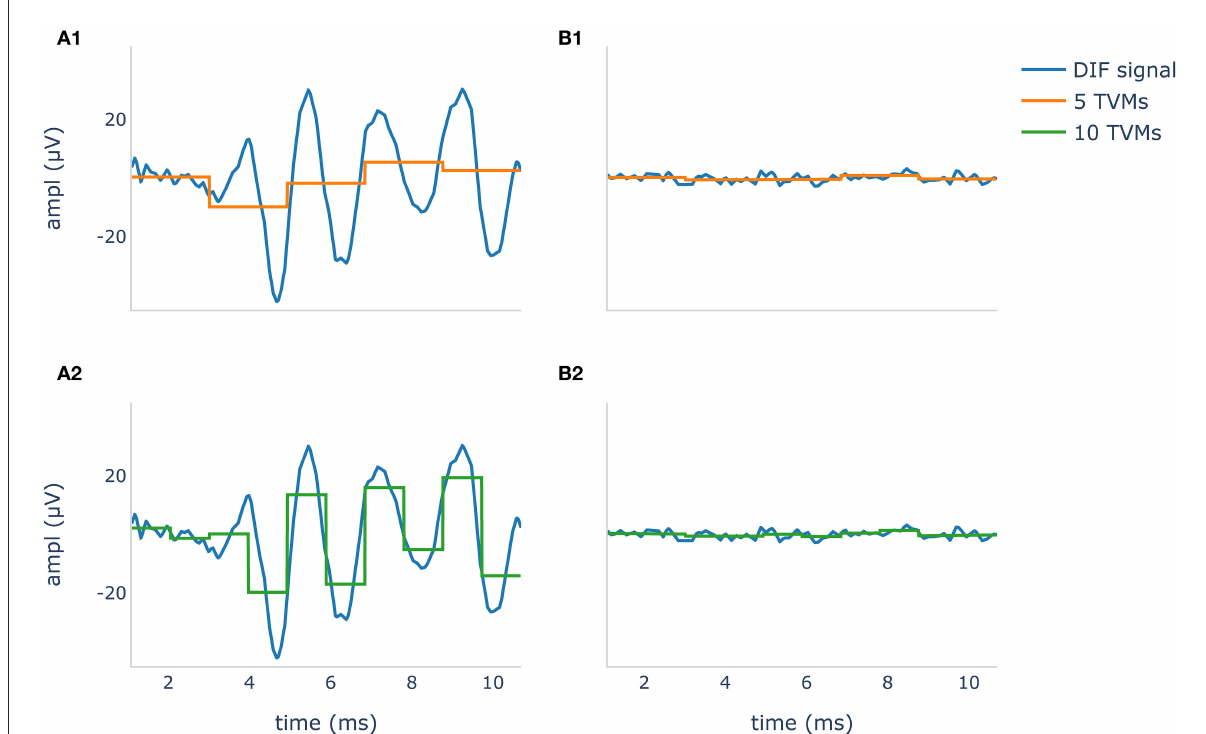
FIGURE1 Difference potential (DIF) curves in blue show a recognizable CM/DIF signal (A1,A2) and noise with no visible CM/DIF component (B1, B2) in response to a 500 Hz stimulus. The orange curve in (A1,B1) shows 5 time-voltage-means (TVMs), and the green curve in (A2,B2) shows 10 TVMs used to calculate Hotelling’s T 2 test. It is evident that in this example, an increase of the TMVs leads to better mapping of the CM/DIF signal with higher